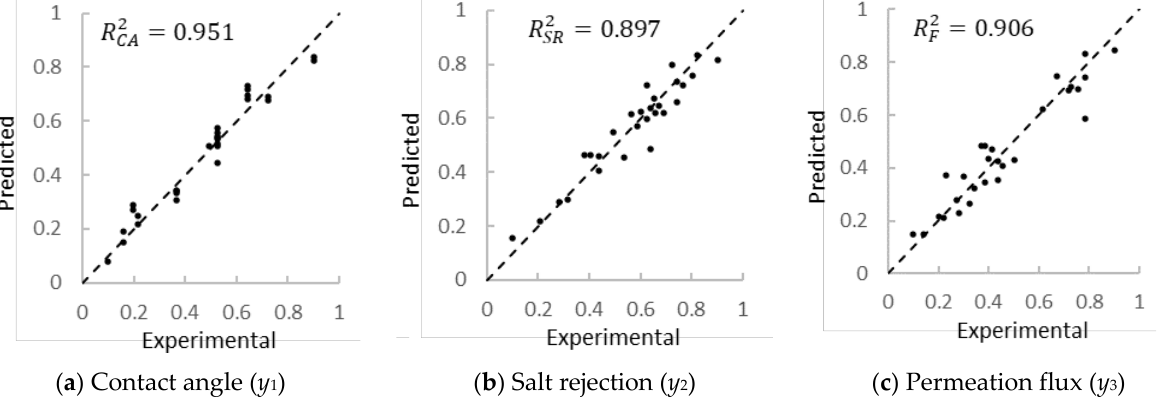
Figure 1. The goodness of fit tests for a single-layer ANN Model 1.